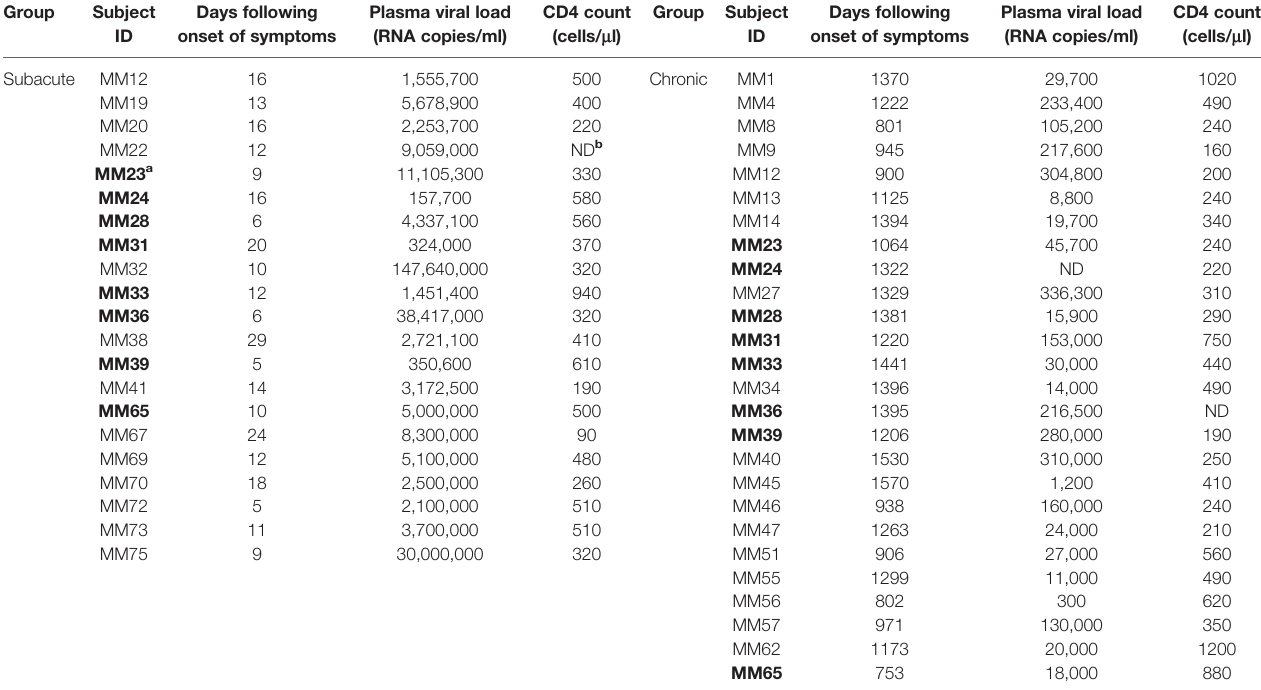
TABLE 1 | Clinical data from donors subacutely and chronically infected with HIV-1.